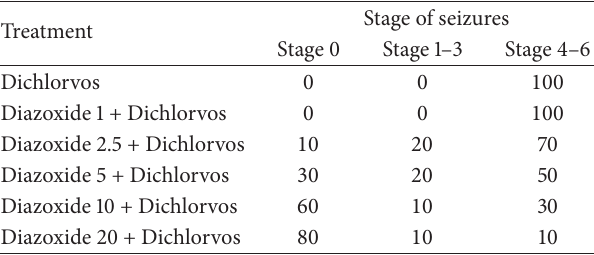
Table 1: Effect of different doses of Diazoxide (mg/kg) on the various stages of seizures induced by Dichlorvos injection in mic (data are shown as percentage of mice, 𝑛 = 10 ). Stage 0: no abnor- mal behavior; Stage 1: excessive salivation, chewing, and pawing of whiskers and mouth; Stage 2: dazed appearance, intermittent motionlessness, tremor, and/or bobbing of the head; Stage 3: like Stage 2, with random and/or generalized jerks; Stage 4: intermittent rearing on hind legs with forepaws extended (with clonic jerking) without falling; Stage 5: like Stage 4, with falling to the side or rear; Stage 6: status